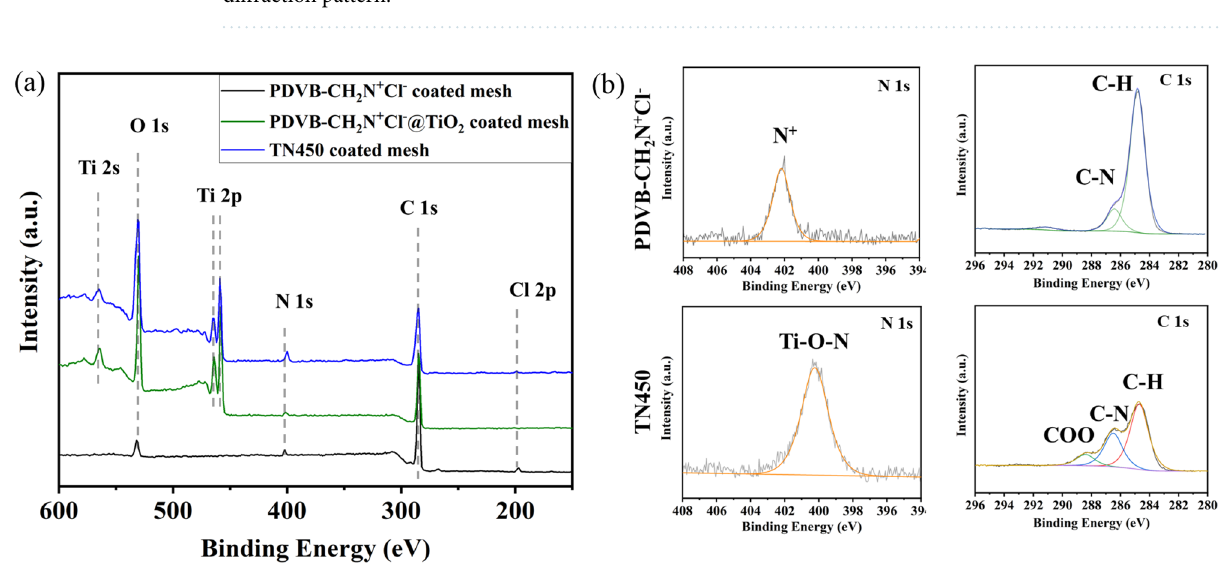
Figure 3. ( a ) XPS spectra of PDVB-CH 2 N + Cl − coated mesh, PDVB-CH 2 N + Cl − @TiO 2 coated mesh and TN450 coated mesh; ( b ) the deconvoluted C 1 s and N 1 s spectra of PDVB-CH 2 N + Cl − coated mesh and TN450 coated